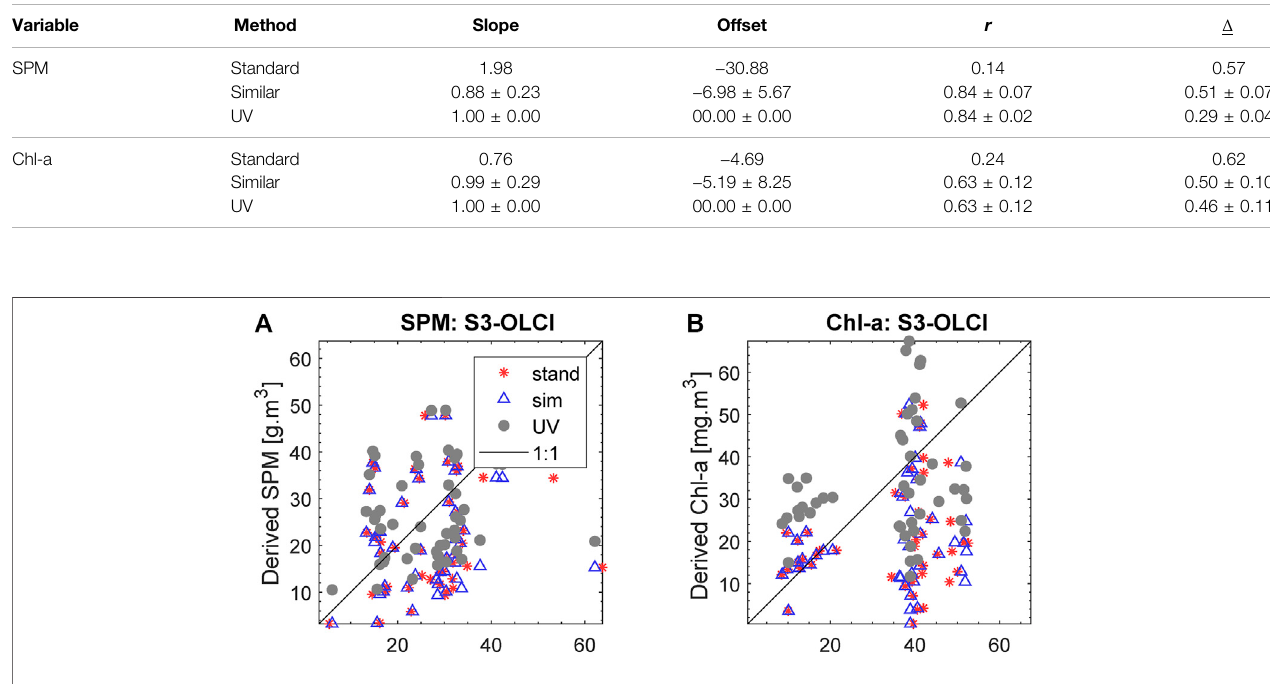
Frontiers in Remote Sensing |